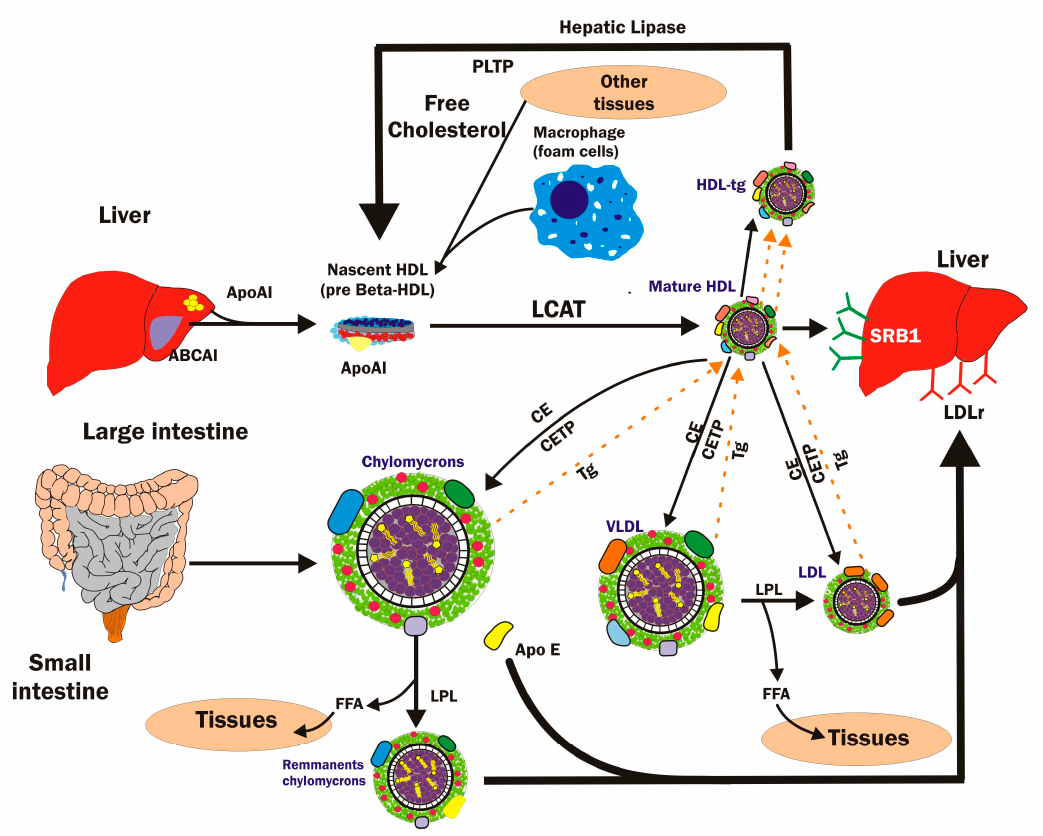
Figure 3. Biogenesis and catabolism (reverse cholesterol transport) of high-density lipoproteins. ABCA1 = ATP binding cassette subfamily A member 1; ApoAl = apolipoprotein Al; ApoE = apolipoprotein E; CE = cholesterol ester; CETP = cholesteryl ester transfer protein; FFA = free fatty acids; LCAT = lecithin-cholesterol acyltransferase; LDL = low density lipoprotein; LDLr = LDL receptor LPL = lipoprotein lipase; PLTP = phospholipid transfer protein; SR-B1 = scavenger receptor class B member 1; Tg = triglycerides; VLDL = very low-density lipoprotein.